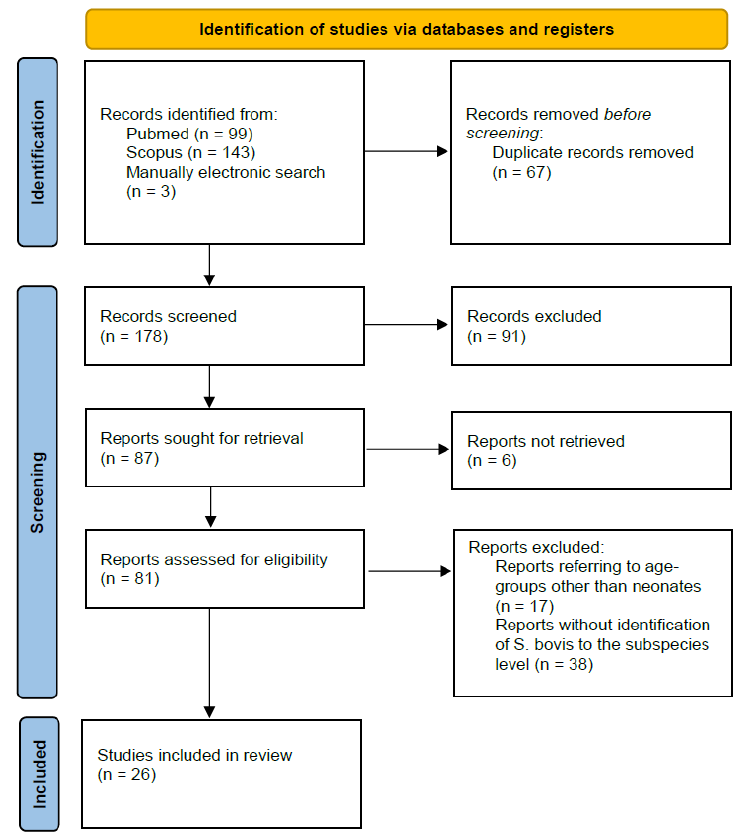
Figure 1. Flowchart of the selection process.